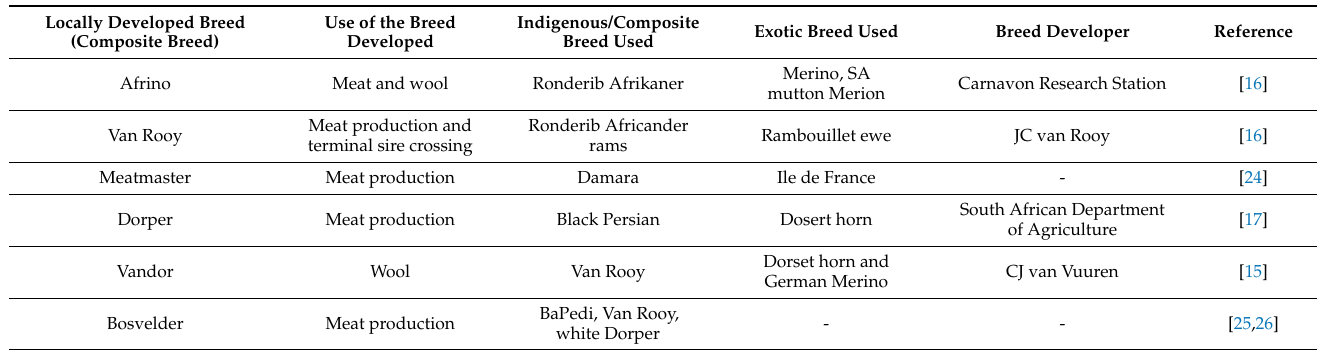
Table 1. Role of South African indigenous breeds in developing composite